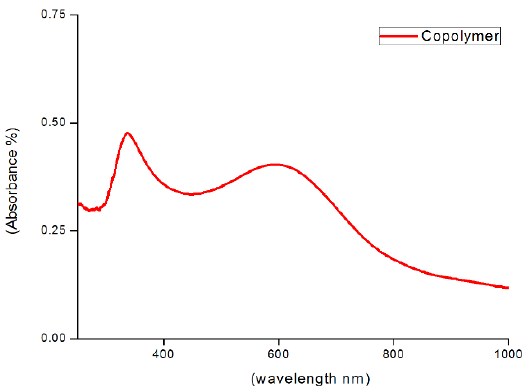
Figure 2. UV-Visible spectrum of copolymer in